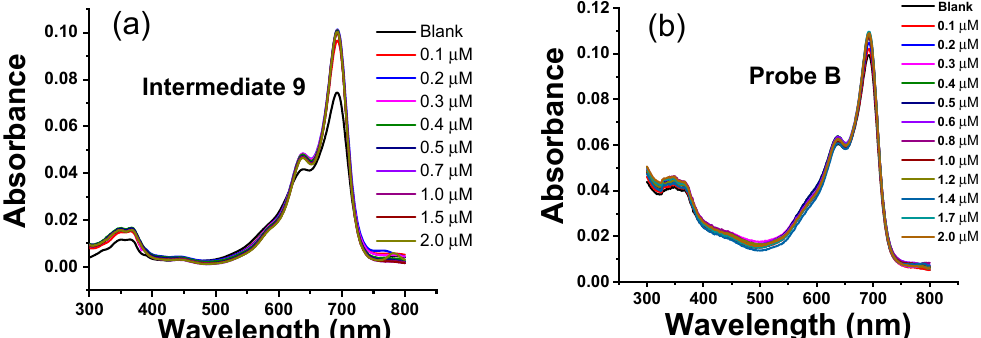
Figure 2. ( a ) UV-Vis absorption spectra of 1.0 µ M intermediate 9 and ( b ) UV-Vis absorption spectra of 1.0 µ M probe B upon gradual addition of Zn(II) from 0.1 µ M to 2.0 µ M to 10 mM HEPES bu ff er solutions (pH 7.0) containing 1.0 µ M) probe B .